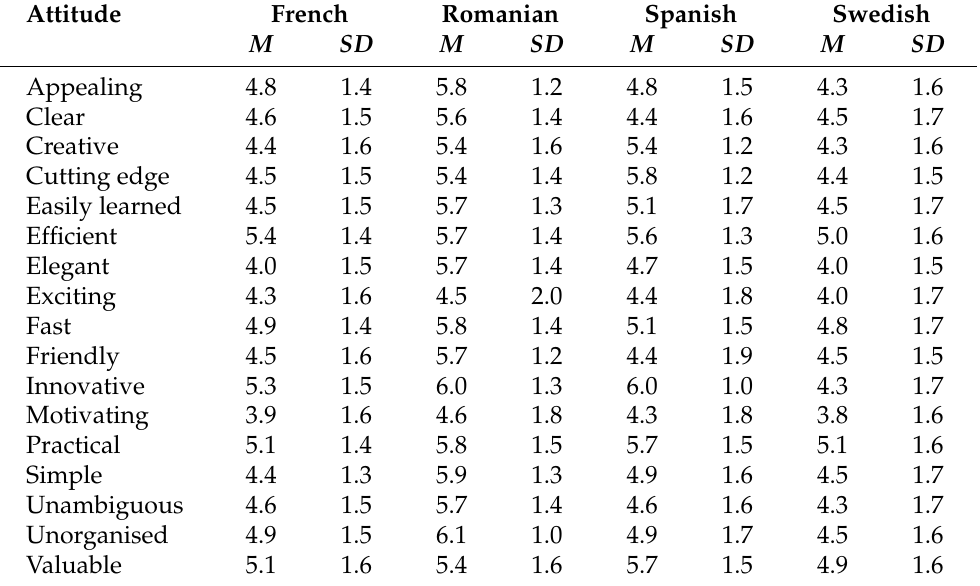
Table A12. Means and Standard Deviations for InVID-WeVerify attitudes on post-test with separate estimates for each language. The rating scale ranged from 1 (not at all) to 7 (very much).